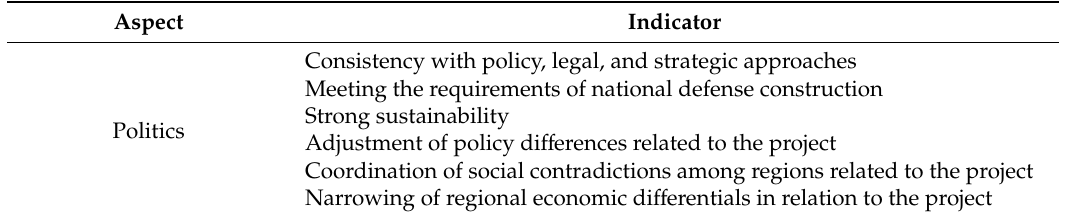
Table 2. Indicators from policy